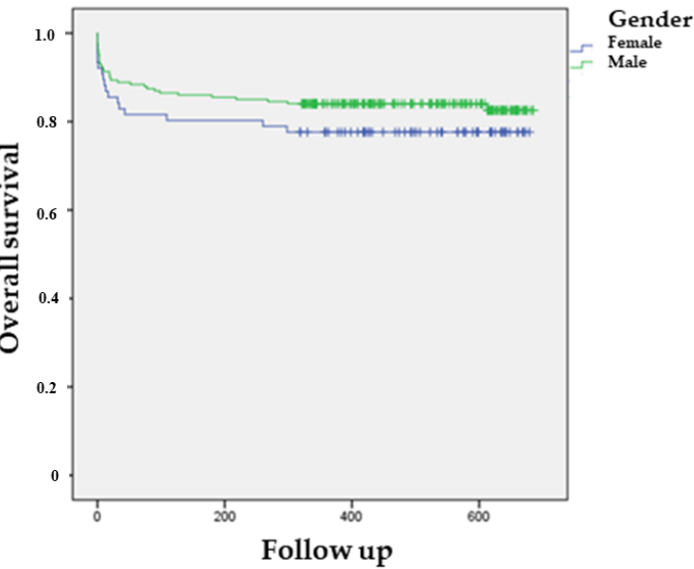
Figure 2. Kaplan–Meier curve representing in-hospital and 1-year mortality according to